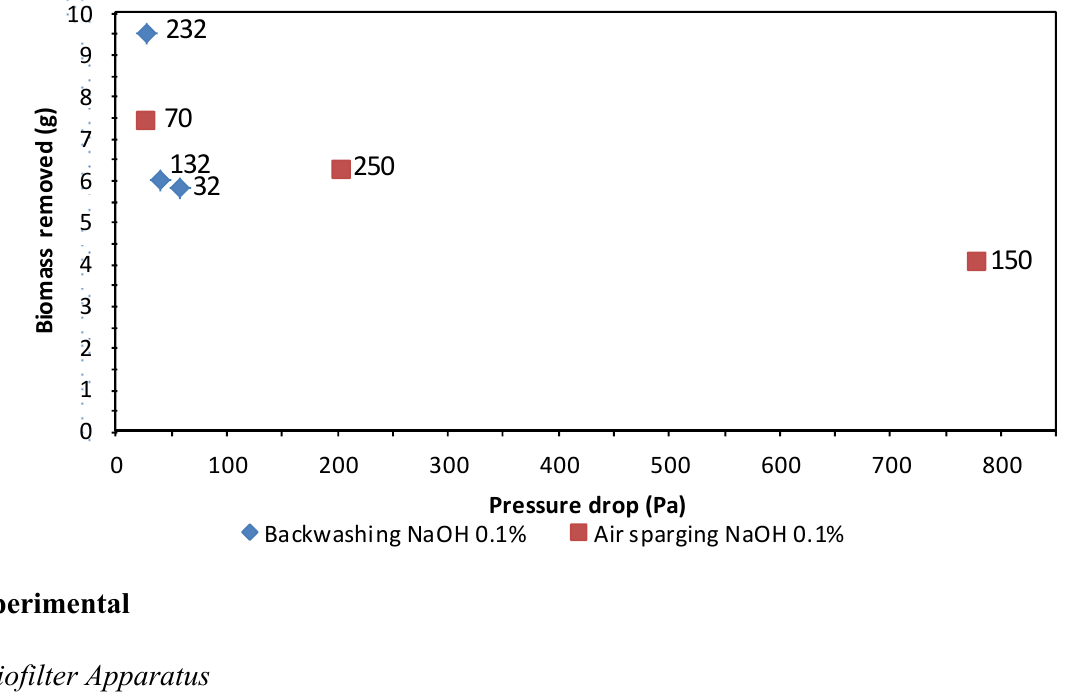
Figure 16. Effect of high pressure drop over the amount of removed biomass when treatments performed were applied at different flow rates. In the graphic, right hand data indicate the water or air flow rate value (L h − 1